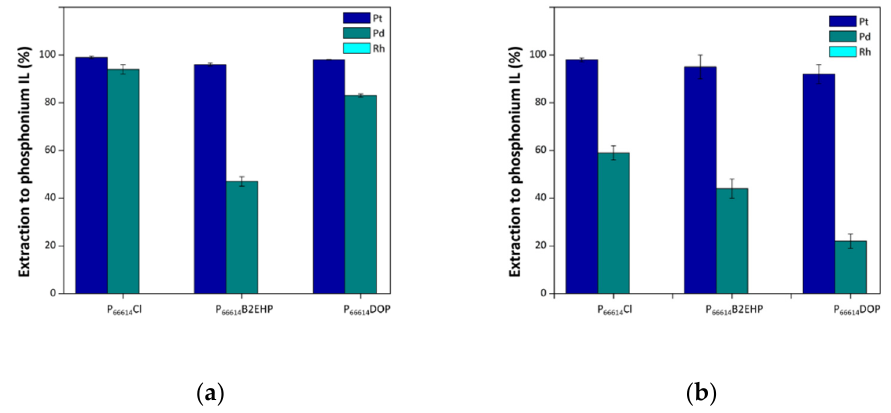
Figure 5. Extraction efficiencies (%) of PGMs to phosphonium ILs from PGM model, at 3.7 M HCl (left) and at 9.7 M HCl